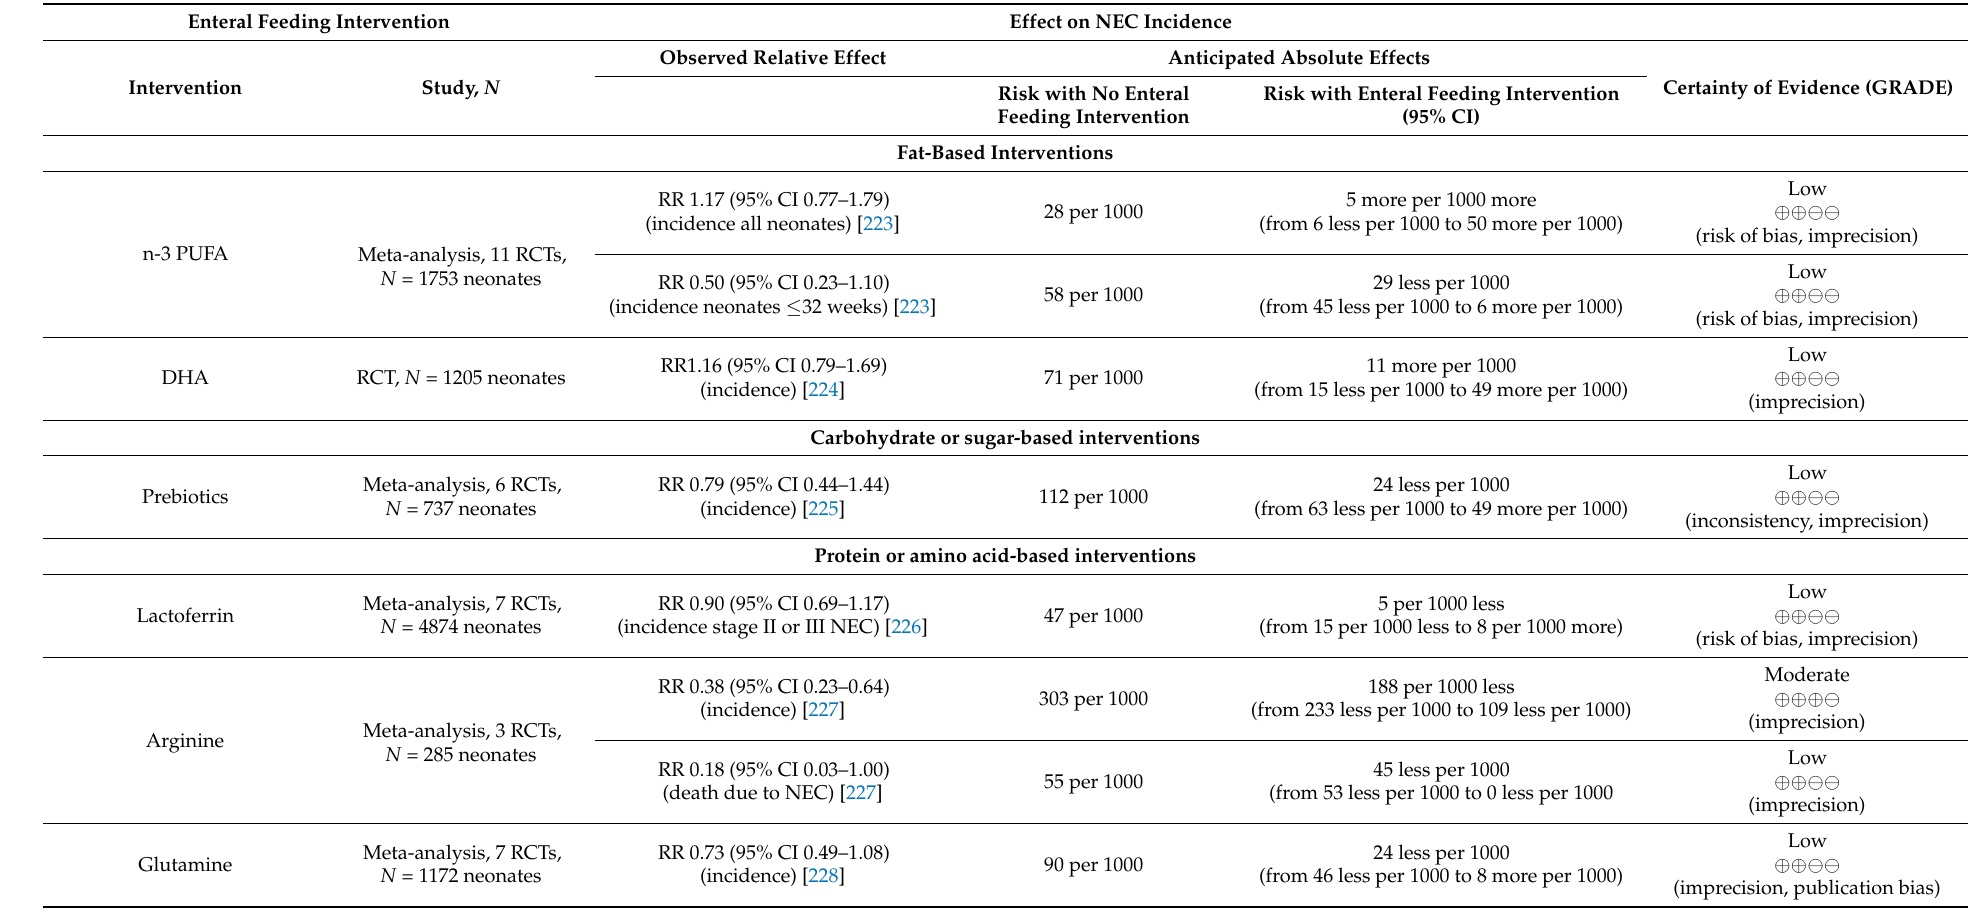
Table 14. Enteral feeding interventions reducing NEC incidence or mortality in human